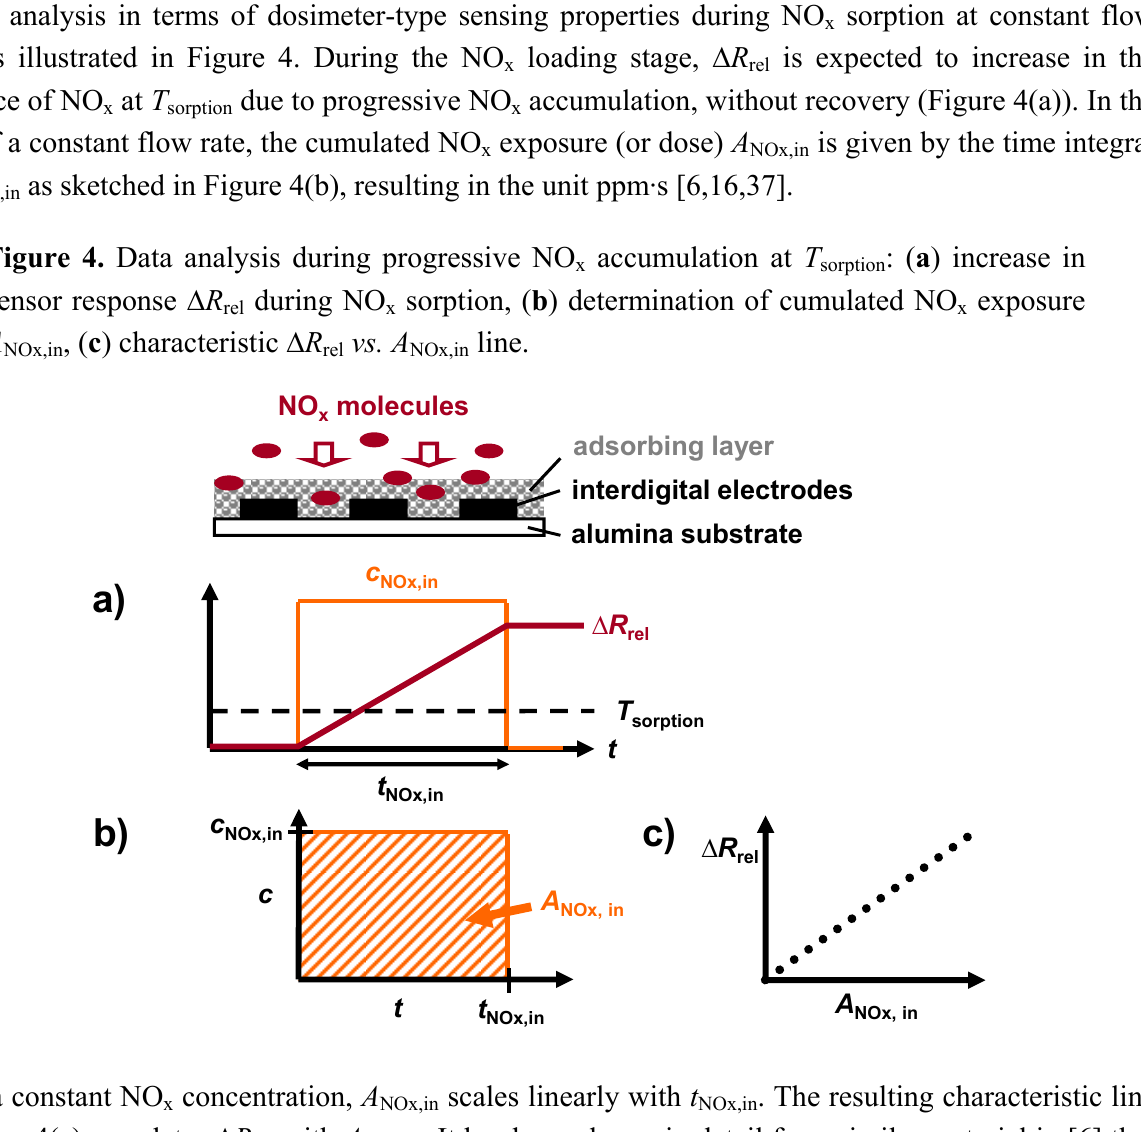
accumulation at T x